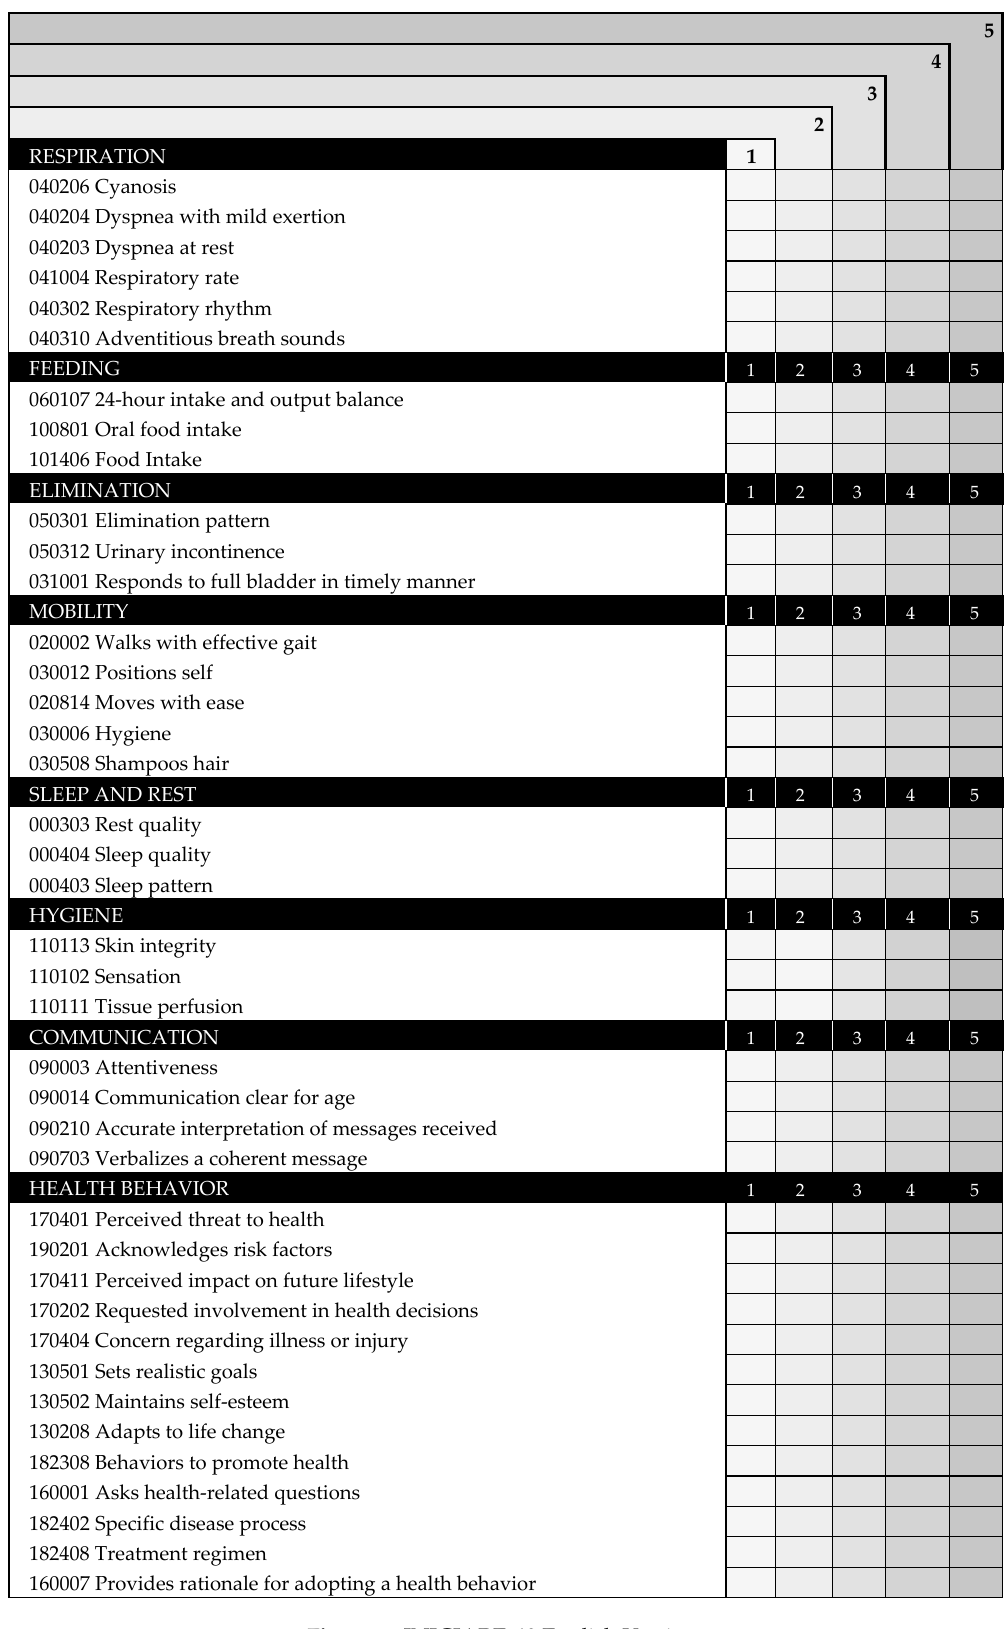
Figure 5. INICIARE-40 English